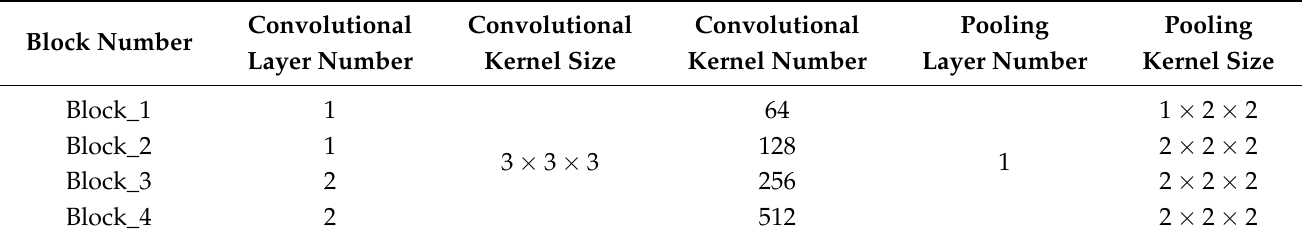
Table 1. Specific parameter configuration of each layer of the 3D SFE-Module.